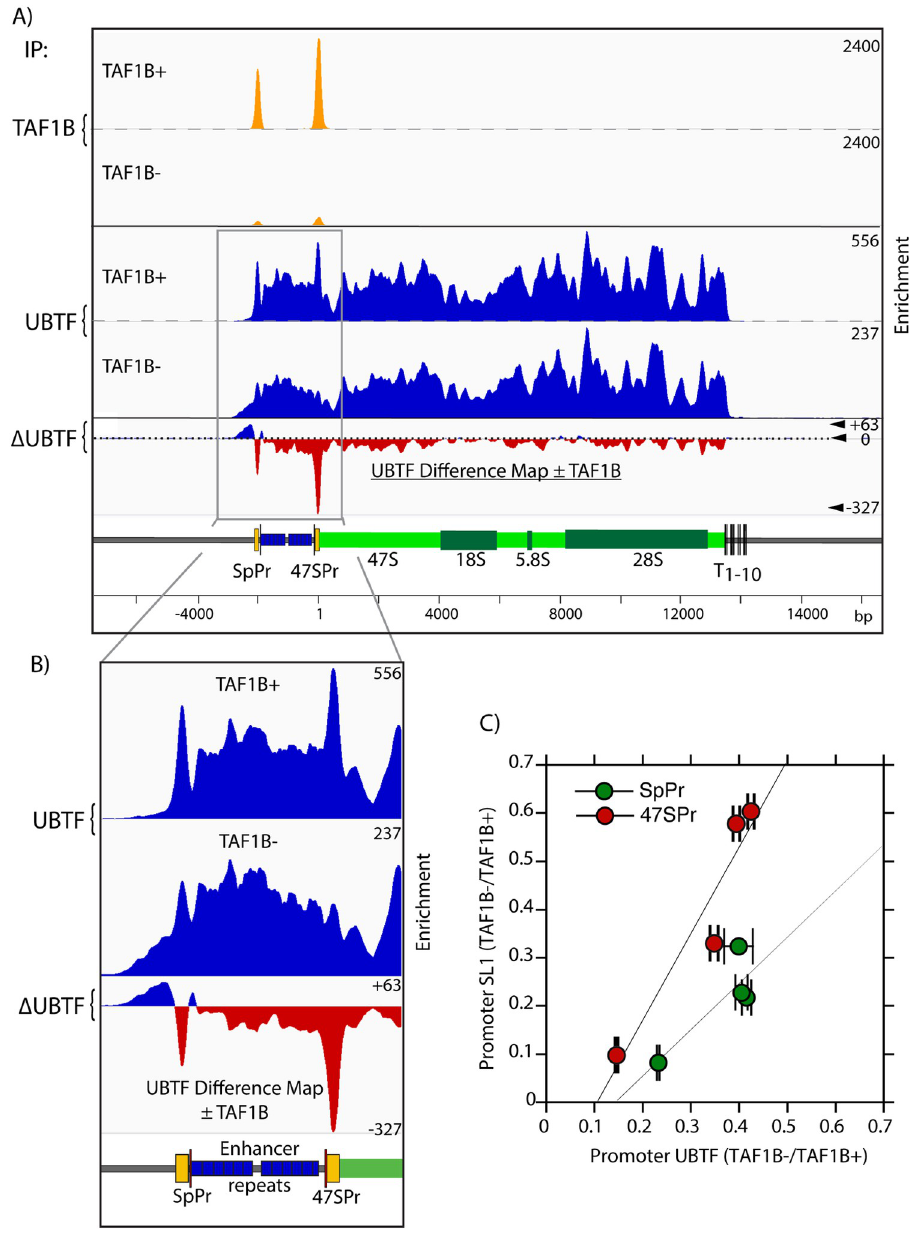
Fig 3. TAF1B loss induces depletion of UBTF from both Spacer and 47S promoters but not from the adjacent enhancer repeats nor from the 47S gene body. A) DChIP-Seq analysis of TAF1B and UBTF occupancy across the rDNA repeat in Taf1b fl/fl /p53 -/- /ERcre +/+ MEFs before (TAF1B+) and 5 days after Taf1b inactivation (TAF1B-). Δ UBTF indicates the difference map of UBTF occupancy after TAF1B depletion minus the occupancy before TAF1B depletion. B) Magnified view of the DChIP mapping in A showing detail over the promoter and enhancer regions. C) Analysis of Spacer and 47S promoter occupancies reveals a direct proportionality between TAF1B and UBTF. Four independent DChIP UBTF and TAF1B data sets displaying different levels of TAF1B depletion were quantitatively analyzed for UBTF and TAF1B promoter occupancy by peak fit, examples of which are shown in S8 Fig. The fractions of SL1 (TAF1B) and UBTF on each promoter after TAF1B depletion are plotted one against the other and reveal near linear relationships. Error bars in C show the SEM associated with peak